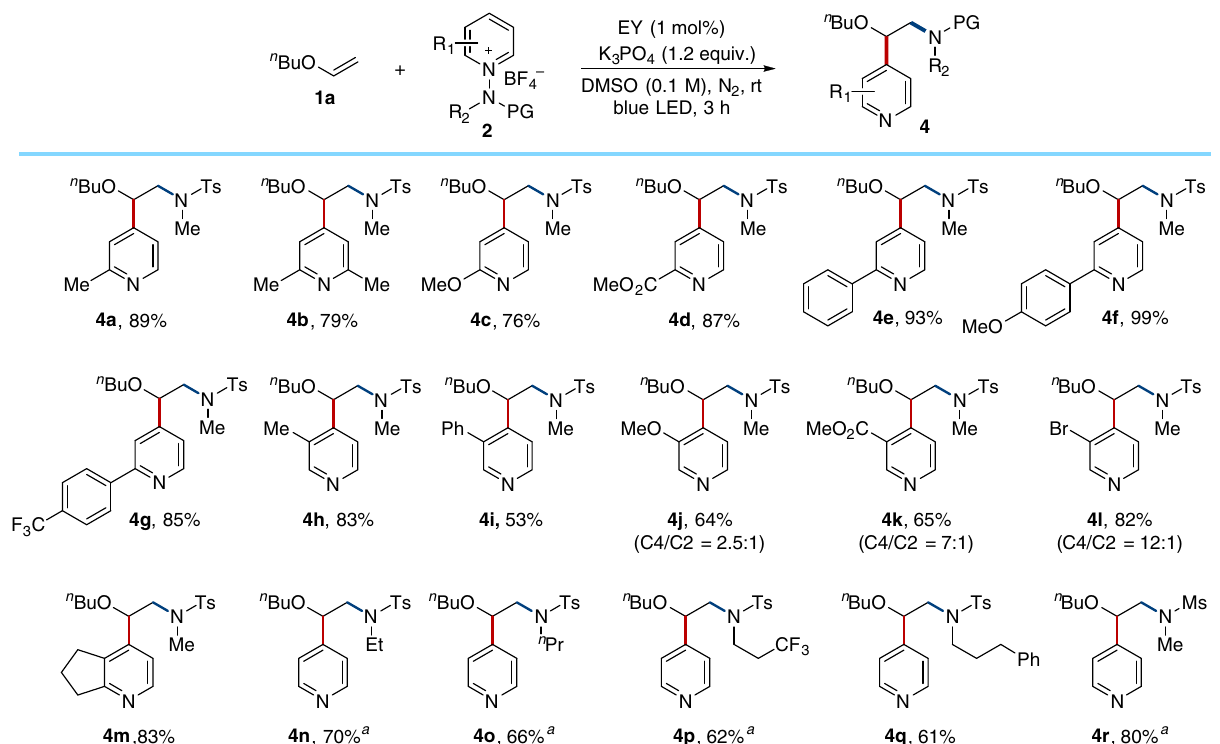
Fig. 6 Substrate scope of bifunctional reagents. Reaction conditions: 1a (0.1 mmol), 2 (0.15 mmol), EY (1 mol%), K 3 PO 4 (0.12 mmol), and DMSO (1.0 mL) using blue LEDs at rt for 3 h under N 2 . Yields of isolated products. C4/C2 ratio was measured by 1 H NMR spectroscopy. Unless indicated, C4/C2> 15:1. a